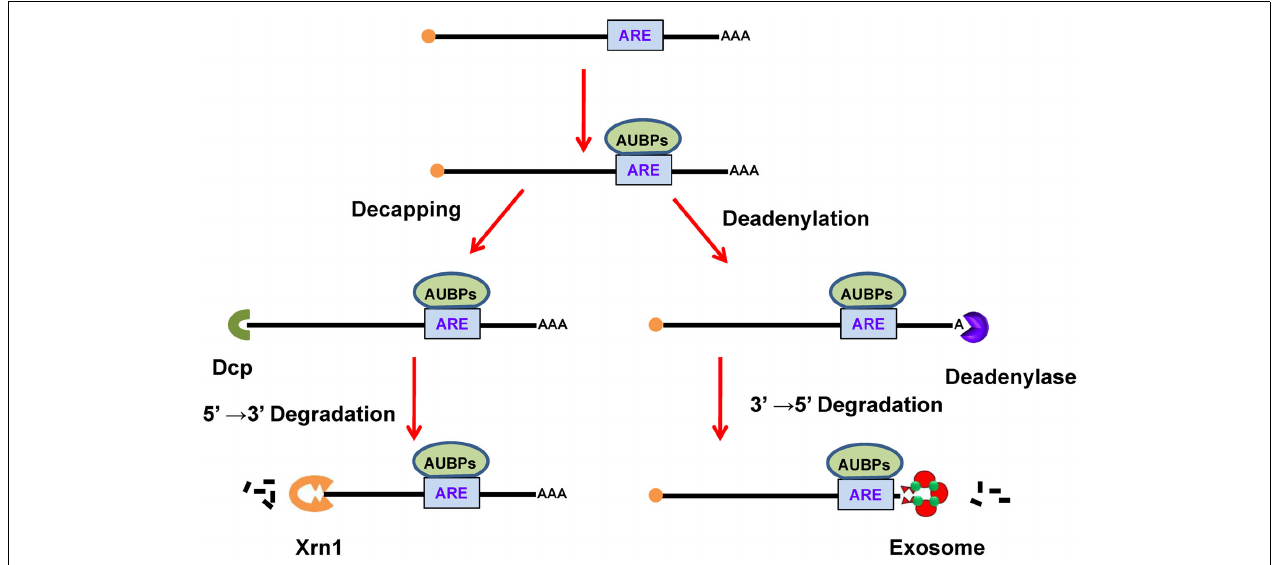
FIGURE 5 |ARE-mediated decay of mRNA. In the cytoplasm, AUBPs (likeTTP) bind to ARE (AUUUA) in the mRNA.The binding of AUBPs recruits either Dcp, which promotes decapping of mRNA, or deadenylase, which removes the poly(A) tail. After exposure of terminal mRNA, exonucleases act to degrade the mRNA in either the 5 (cid:2) –3 (cid:2) direction using Xrn1 or in the 3 (cid:2) –5 (cid:2) direction using the exosome. ARE, AU-rich element; AUBPs, AU-binding